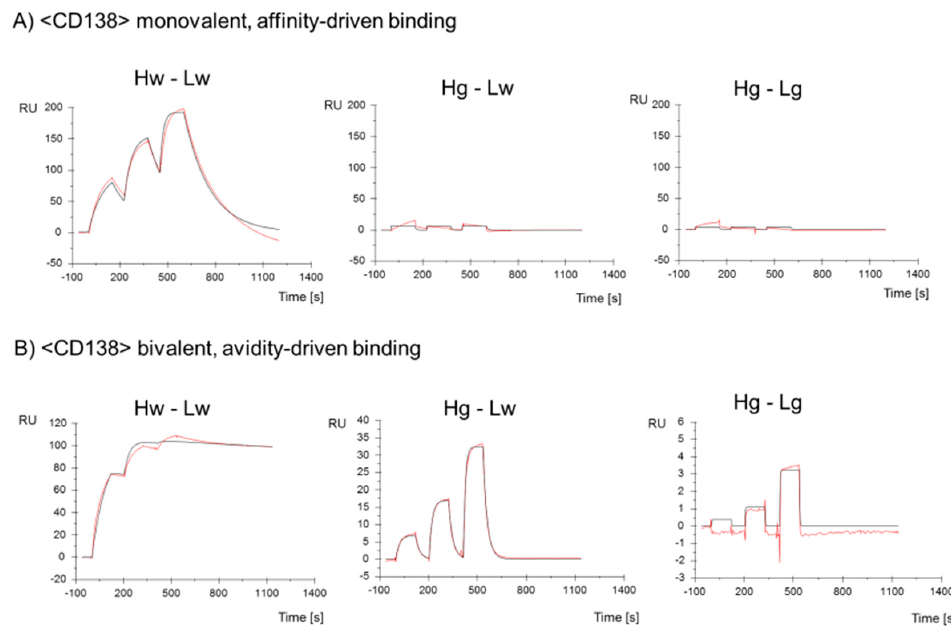
Figure 3. Binding of parent < CD138 > and -B2G variants to the hCD138 antigen. Surface Plasmon Resonance with monomeric CD138 protein as analyte assesses ( A ) monovalent and ( B ) bivalent binding. SPR profiles of Hg-Lw and Hg-Lg variants show a weak remaining resonance when analyzed in the bivalent assay.